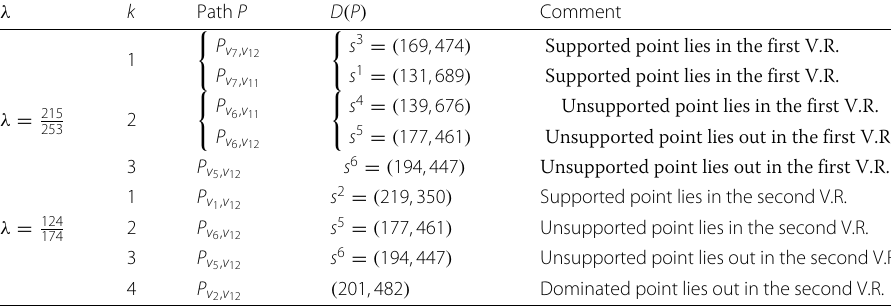
Table 3 Example solutions computed by phase 2